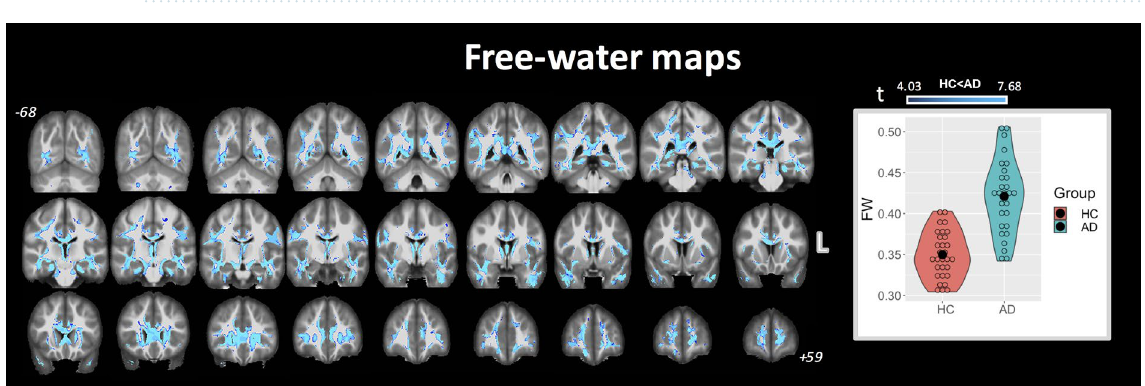
Figure 3. Coronal view of ANCOVA analysis between HC and AD subjects for FW index. Clusters are reported at a significance threshold of p -value < 0.01 corrected for FWE. Higher FW in AD compared to HC was observed widespread across cerebral WM. No significant clusters were found with FW (HC) > FW (AD). The corresponding violin plots represent the FW metrics inside the significant clusters for each with clusters covering 34% of the total WM mask. These differences were observed in several WM regions, including most prominently the fornix, cingulum (both hippocampal and cingulate gyrus parts), and CC. The complete list of group-wise significant clusters for the FW index between HC and AD is reported in Table 3. MA‑index. The results for MA are reported in Fig. 4. Significantly higher values of MA (from both standard DTI and FW-DTI) in AD compared with HC were observed in the right CST, right PLIC, right SCR, and right SFOF, corresponding to more linear anisotropy. On the other hand, lower MA values (from standard DTI and FW-DTI) in AD compared with HC were found mainly in the genu of CC and in the external capsule (EC), cor- responding to more planar anisotropy. It should be noted that similar results for MA were obtained with both standard DTI and FW-DTI analysis. The complete list of group-wise significant clusters is reported in Table 4.